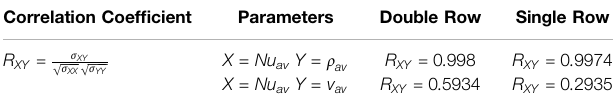
TABLE 1 | Boundary conditions and parameter values for the numerical studies. Parameters Range